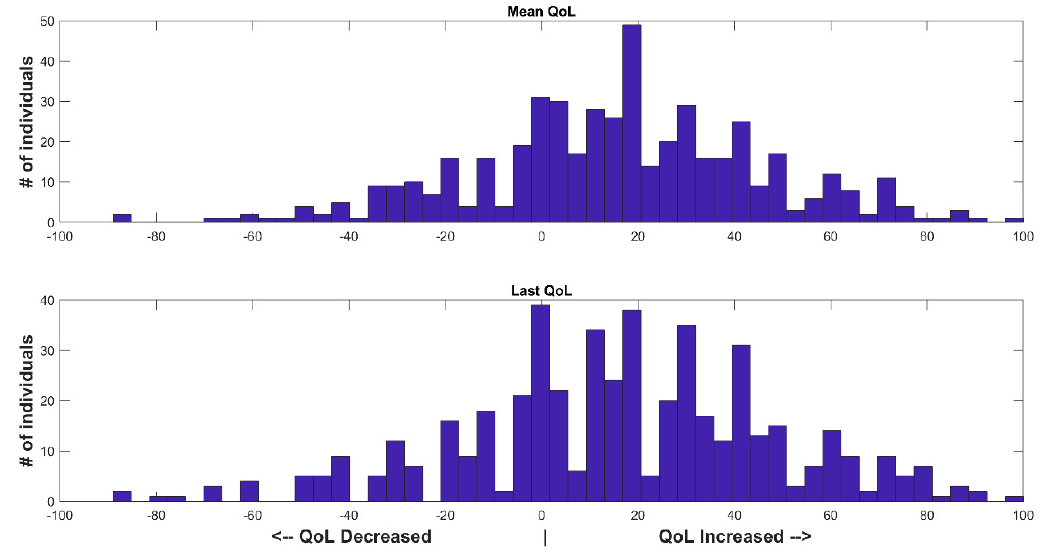
Figure 4. Histogram of the average ( Top ) and last ( Bottom ) change in QoL scores from baseline. We identified 10 factors that passed the Benjamini − Hochberg false discovery rate of 0.05 for association with the QoL score [40].